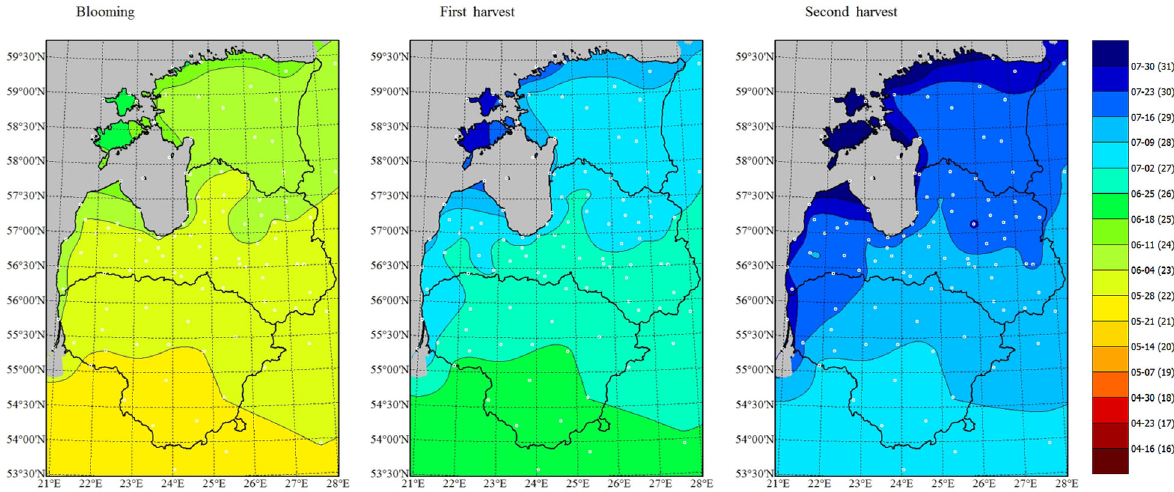
Fig. 4. Timing of strawberry development, weeks of the year, past climate (1951–1980). White dots show the locations of stations used for RCM data bias correction.